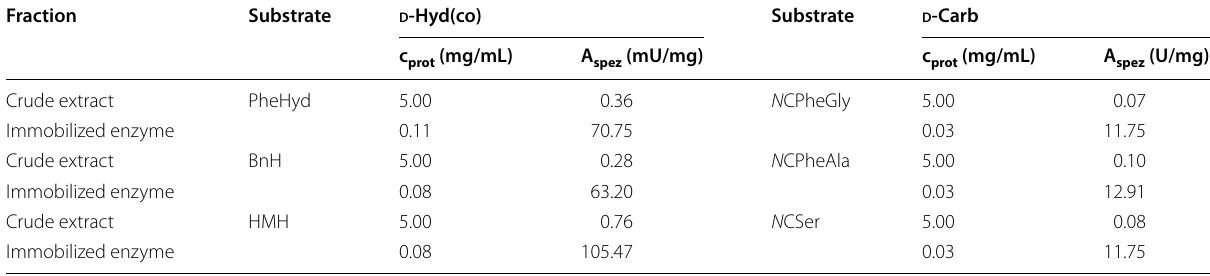
Table 3 Immobilization of d -Hyd(co) and d -Carb via functionalized magnetic beads and hydrolysis of different substrates